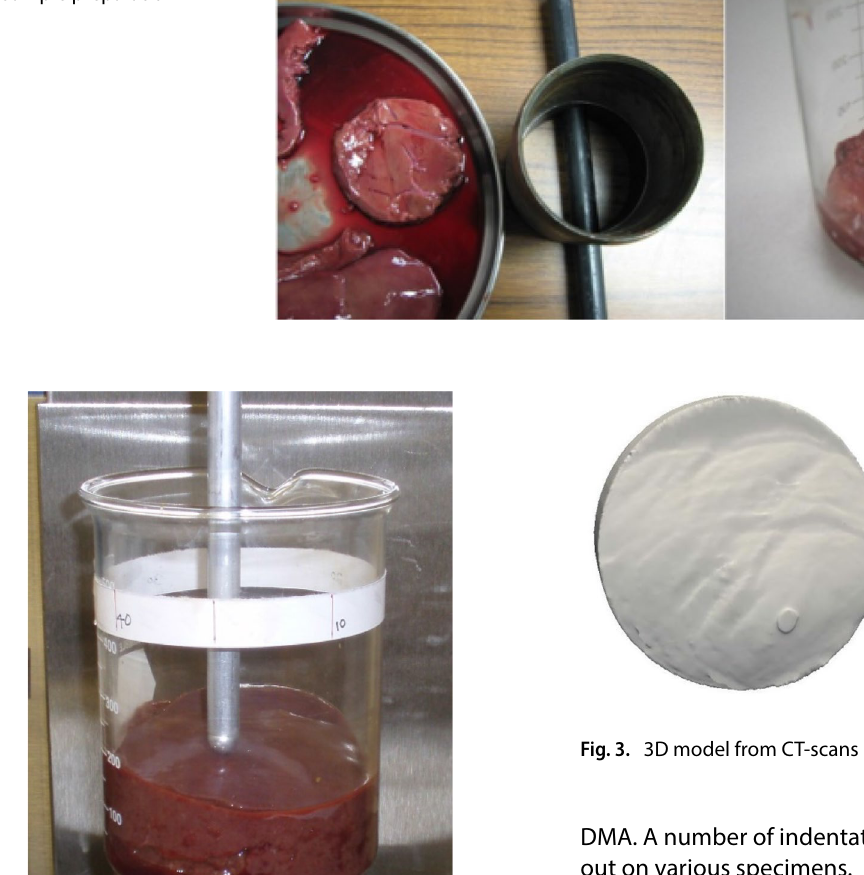
Fig. 1 Sample preparation